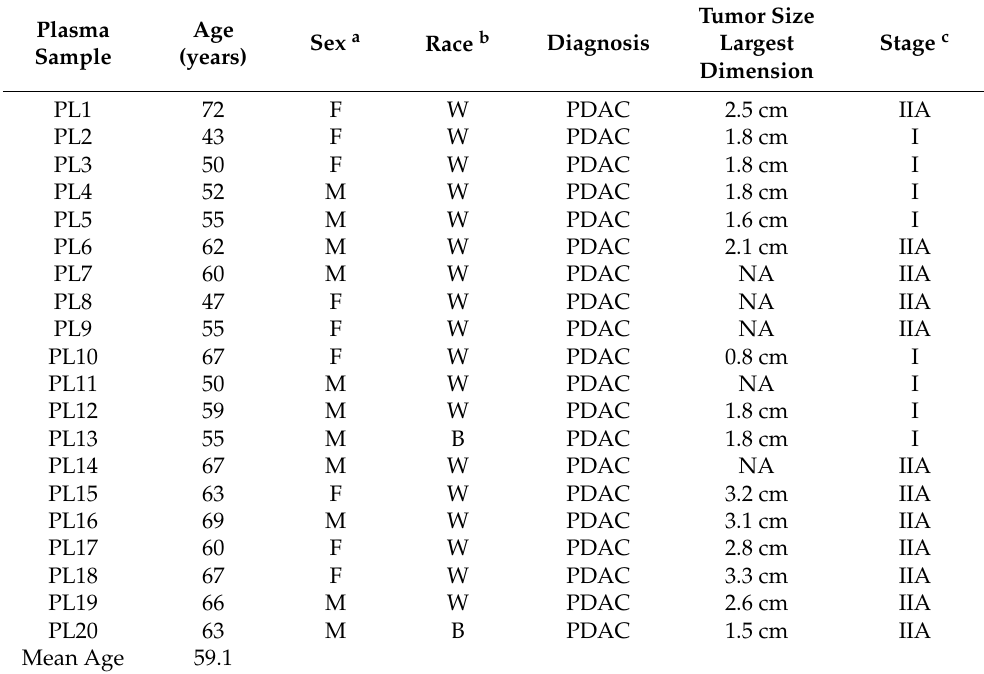
Table 1. Clinical features of PDAC patients (PL1–PL12 included for small RNA-seq; PL1–PL20 for qRT-PCR).